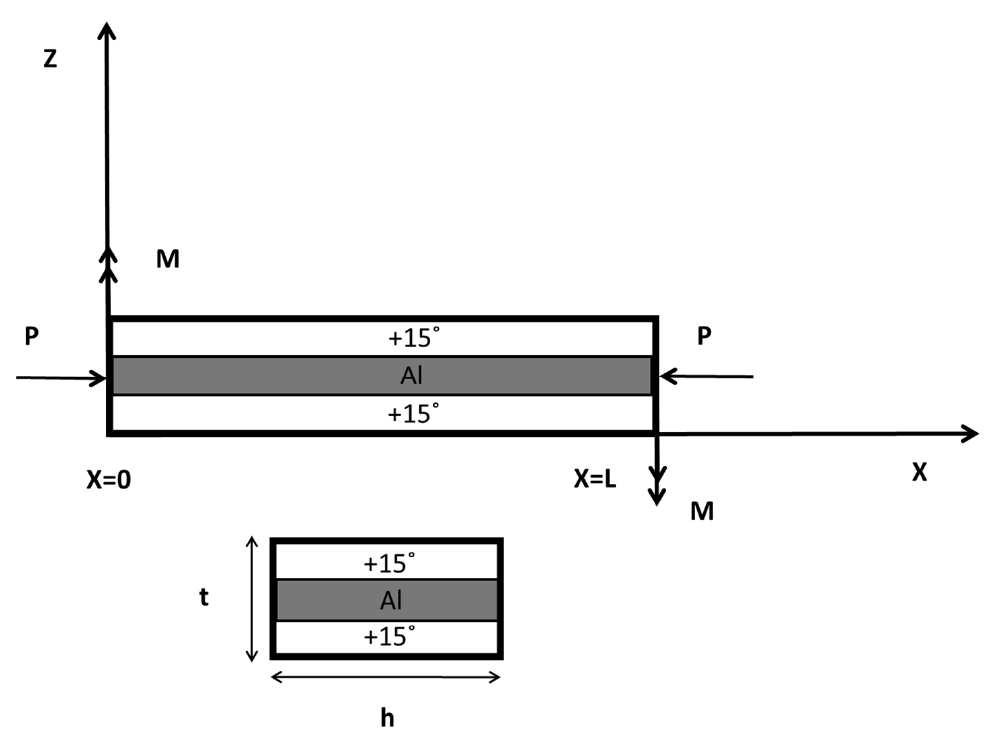
Figure 9. Three-layer, fiber-metal laminated (FML) beam schematic.